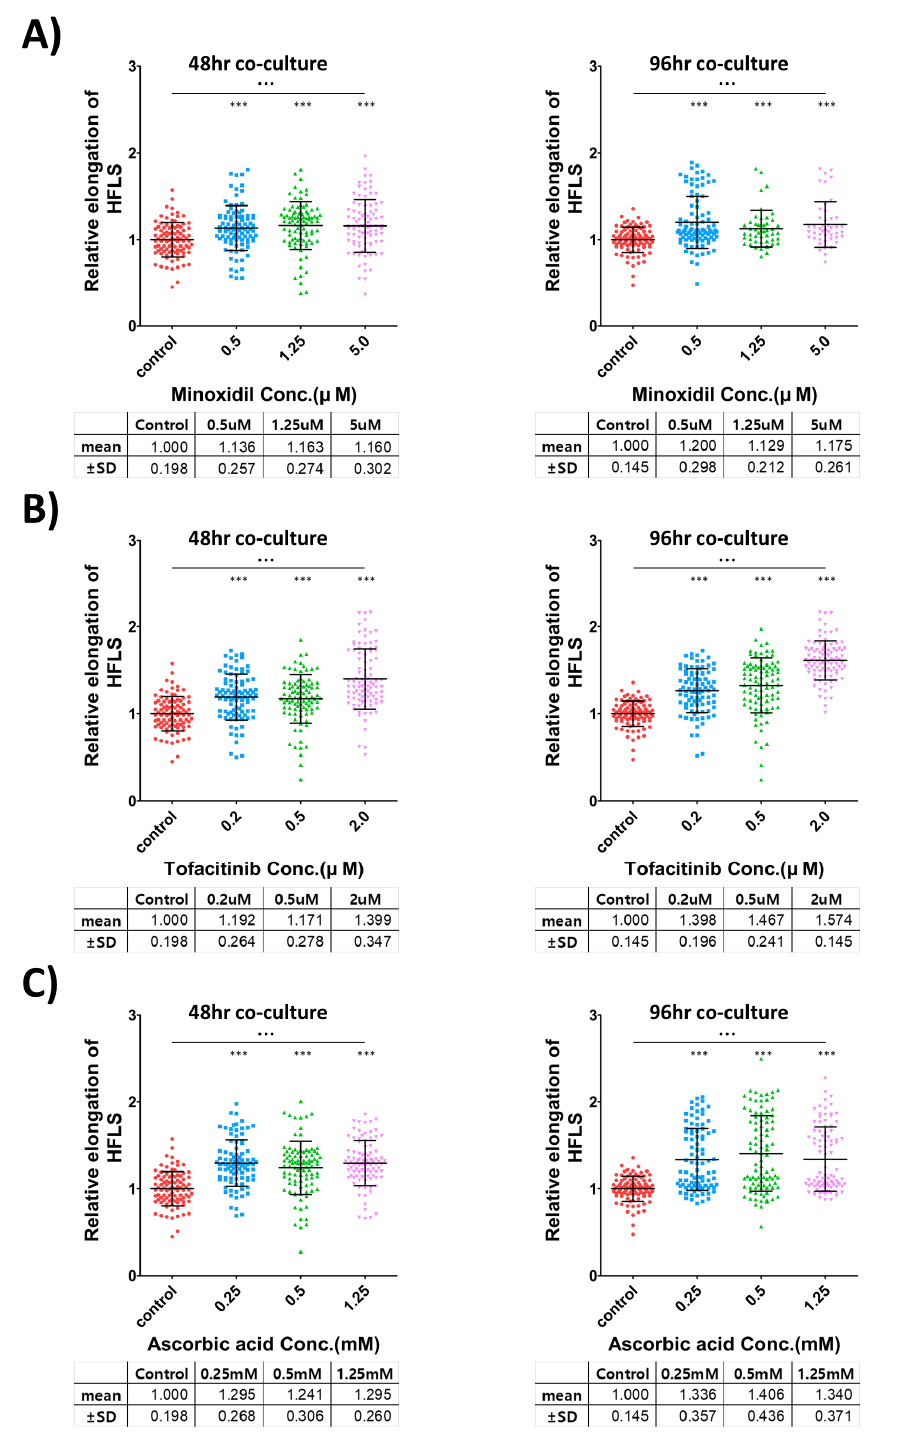
Figure 4. Validation of three known hair-promoting agents using iHFLS. ( A ) Relative iHFLS elongation measurement in the minoxidil treatment groups. ( B ) Relative iHFLS elongation measurement in the tofacitinib treatment groups. ( C ) Relative iHFLS elongation measurement in the ascorbic acid treatment groups. Every group showed statistically significant increased elongation compared with the control groups. *** = p < 0.0001 in the t -test, ··· = p < 0.0001 in the one-way ANOVA analysis. The different color represents different concentration of treated